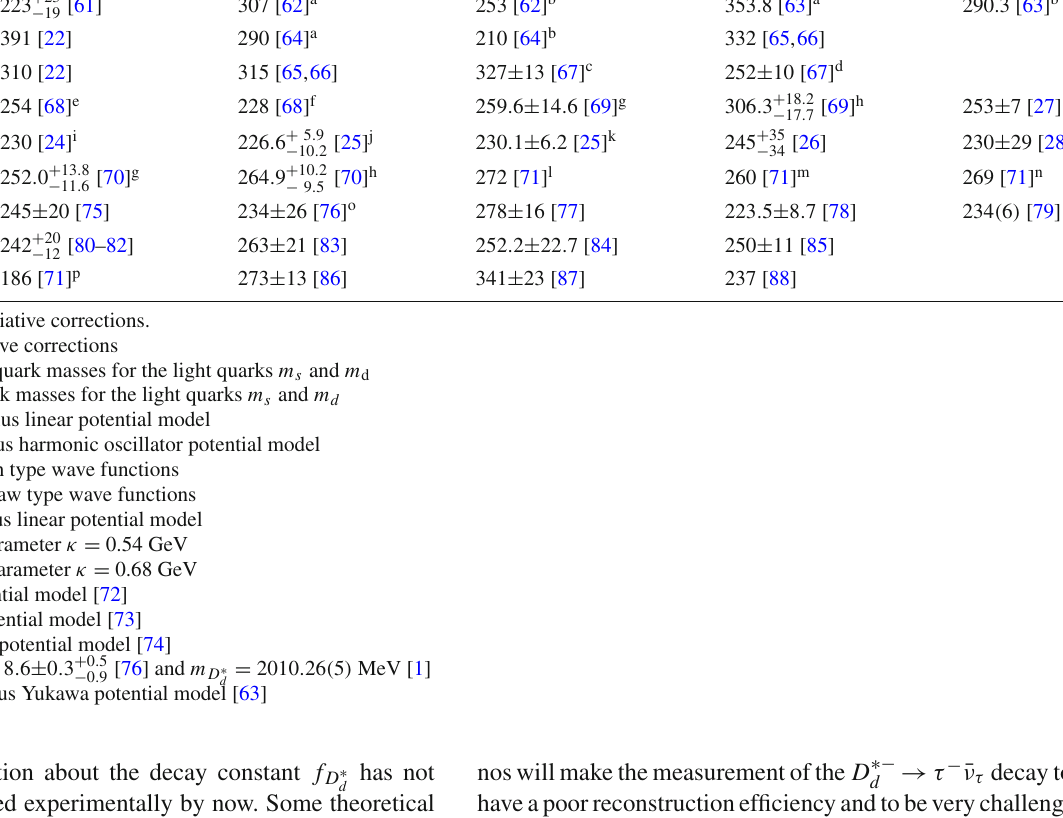
Table 3 The theoretical values of decay constant f D ∗ abbreviation for nonrelativistic quark model NRQM